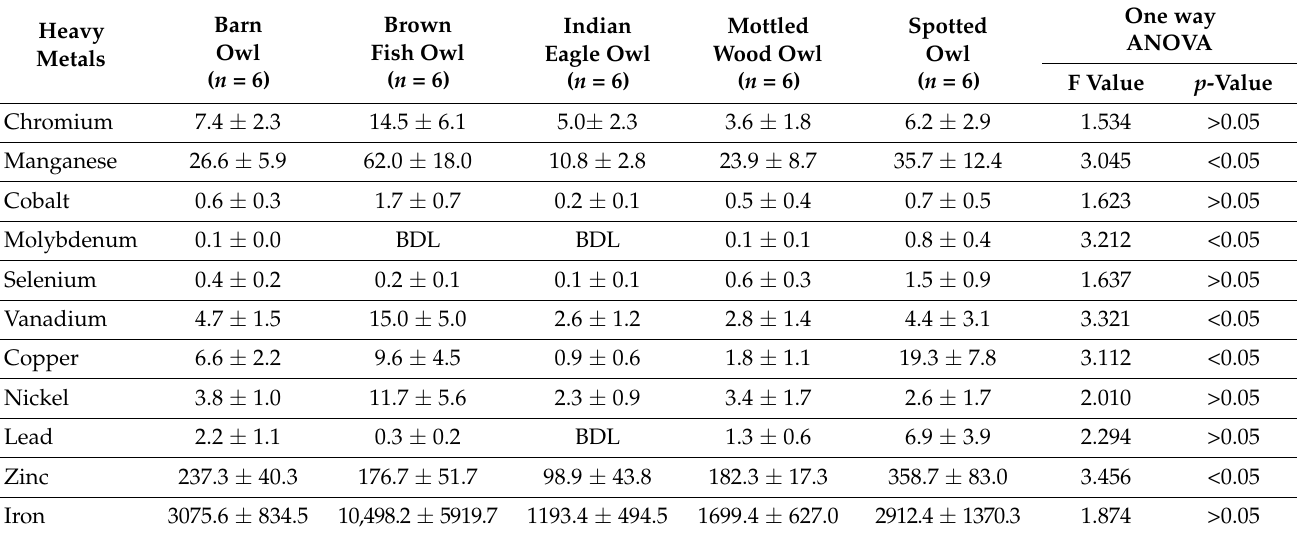
Table 2. Concentration of heavy metals ( µ g/kg, mean ± SE) recorded in five different species of owl.